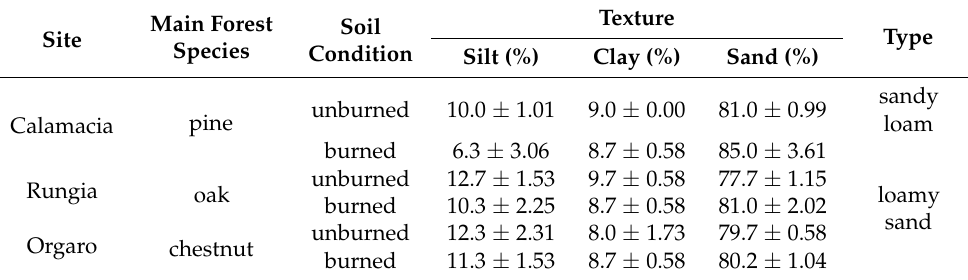
Table 2. Main characteristics of the soils in the experimental sites measured immediately after the prescribed fire and before the mulching treatment (Samo, Calabria, Southern